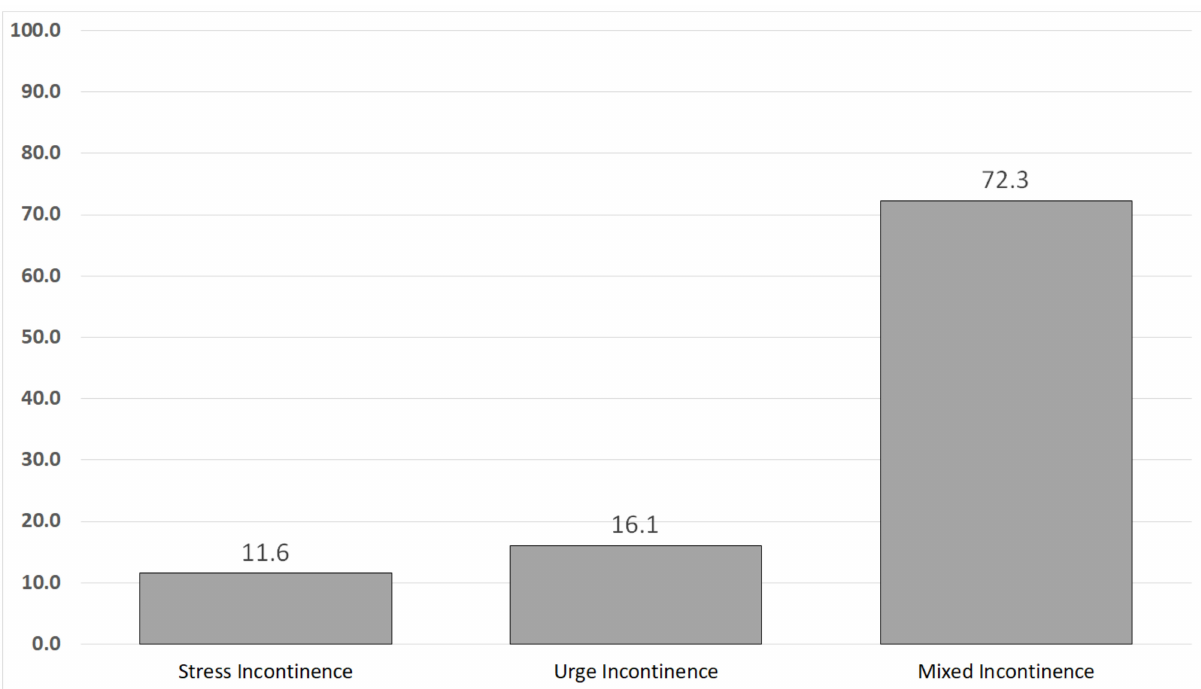
Figure 2. The type of urinary incontinence reported by subjects.